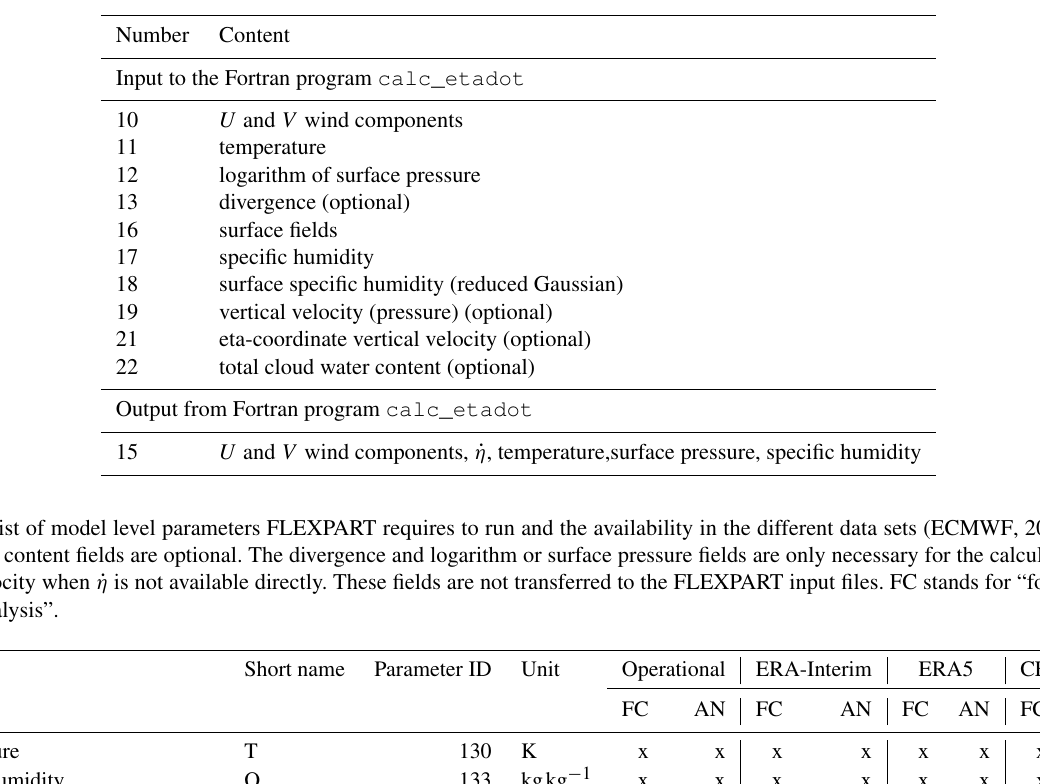
Table 16. List of fort files generated by the Python part to serve as input for the Fortran program and the output file of calc_etadot . If the optional fields were not extracted, the corresponding files are empty.